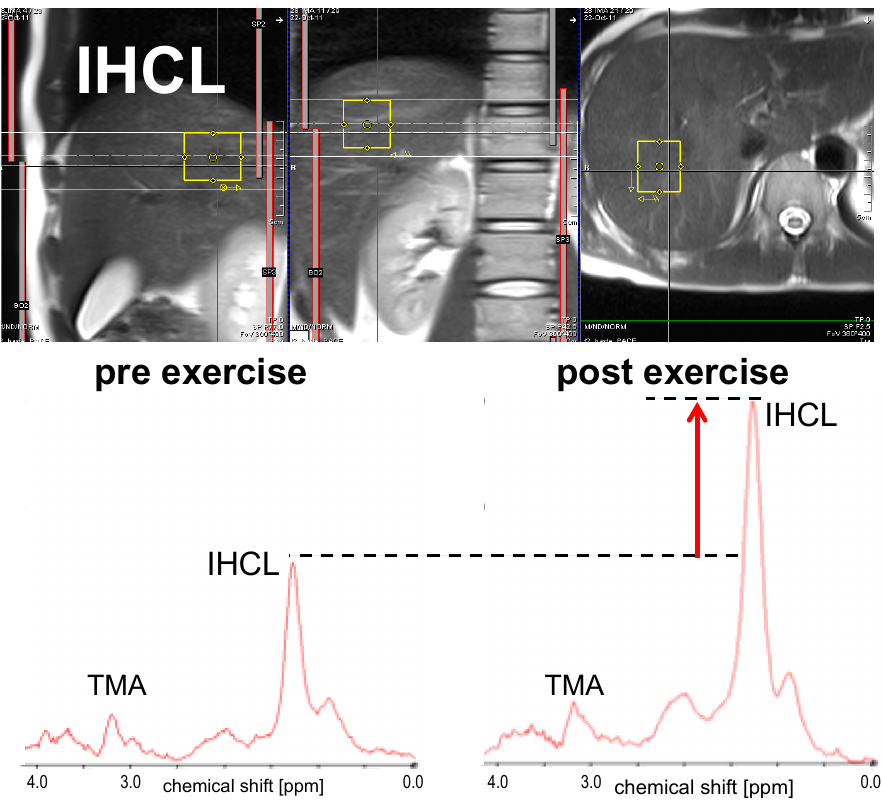
Figure 2. Sample 1 H-MR spectra for the quantification of IHCL obtained before and after an exercise bout of 2 h: The largest peak in the spectrum originates from the aliphatic methylene groups in the fatty acid chains of IHCL. Direct comparison of the pre- and post-exercise spectra shows that IHCL were built up during/after the exercise. Other peaks originate from further protons on the IHCL lipid chains, and trimethyl-ammonium (TMA) groups from metabolites, like betain, or the phosphocholines (for details of the acquisition methods, see [43]; in short: single volume (~19 cm 3 ), stimulated echo localization, echo time 13 ms, 3T, spectra obtained in sync with respiration, triggered for acquisition in expiration). The spin-echo images above the spectra that had also been obtained in expiration show the typical location where the spectra were obtained.